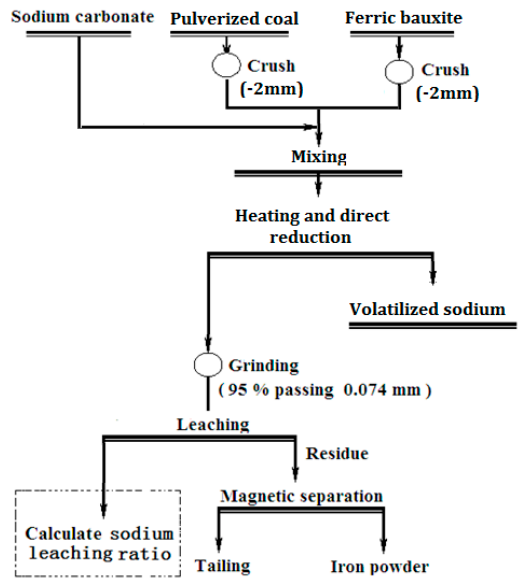
Figure 1. The entire flow chat adopted in the experiment.